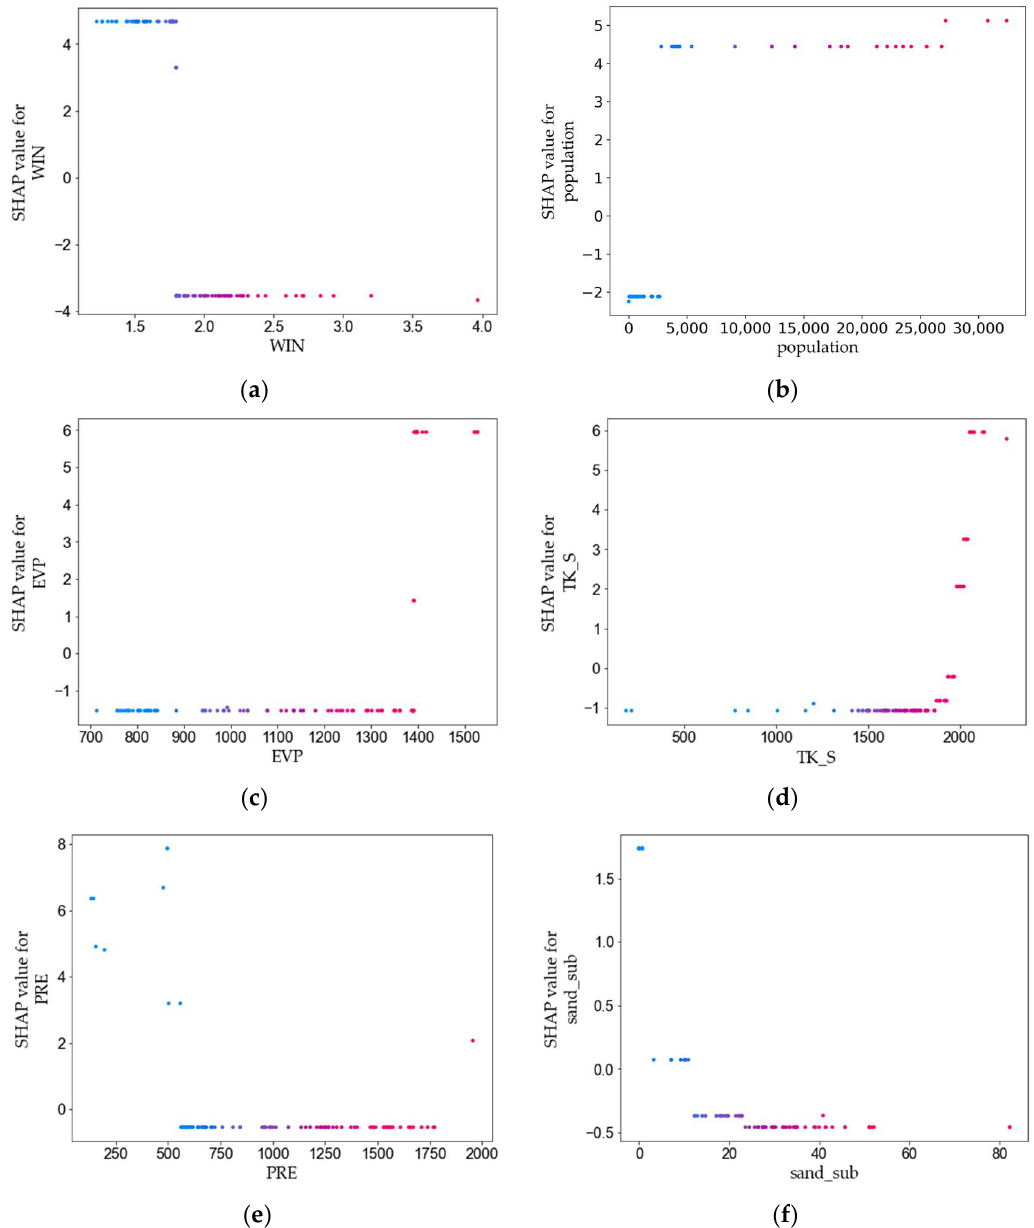
Figure 5. Sca(cid:308)er plots of feature variables and SHAP values. ( a ) WIN; ( b ) population; ( c ) EVP; ( d ) TK_S; ( e ) PRE; ( f ) sand_sub.